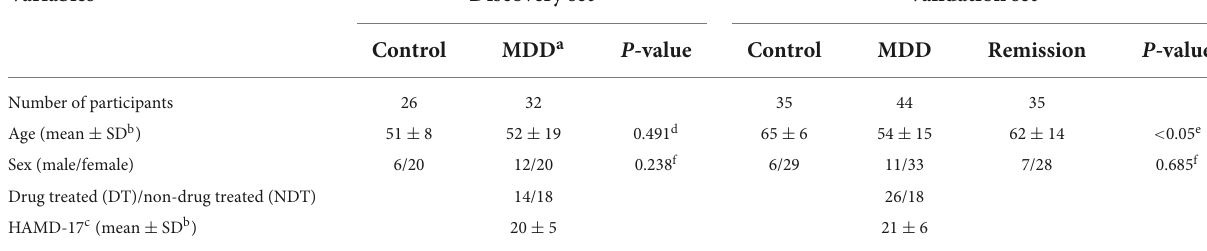
TABLE 1 Demographics of participants.